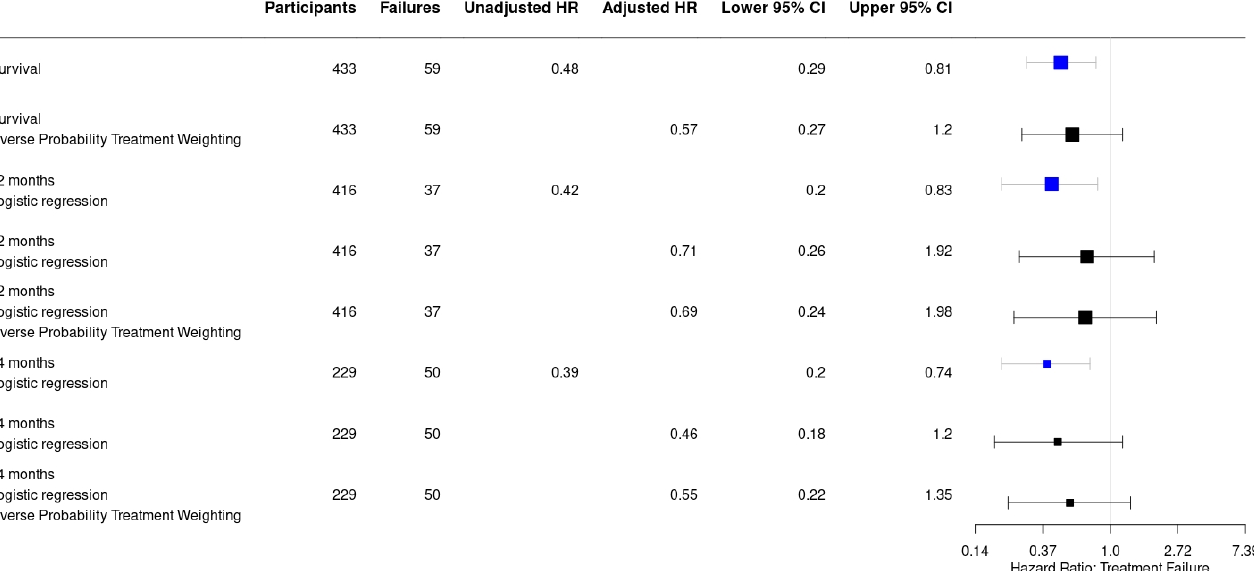
Figure 2. Kaplan–Meier Survivorship curve demonstrating the relationship between patients treated with or without antibiotic-loaded carriers and recurrence of infection.